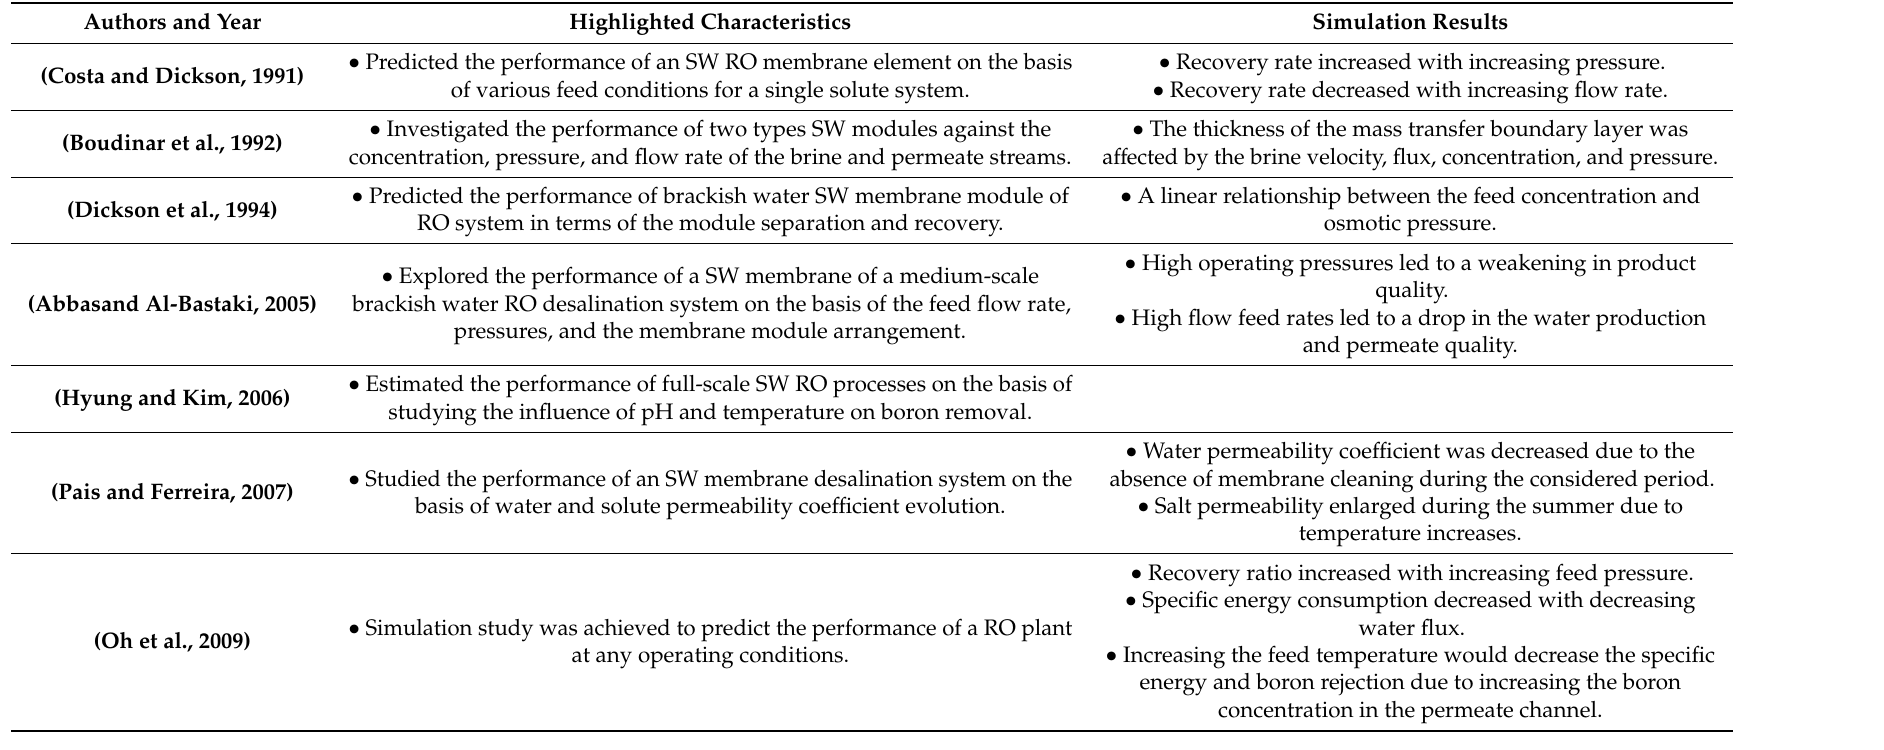
Table 2. Summary of the previous work of RO